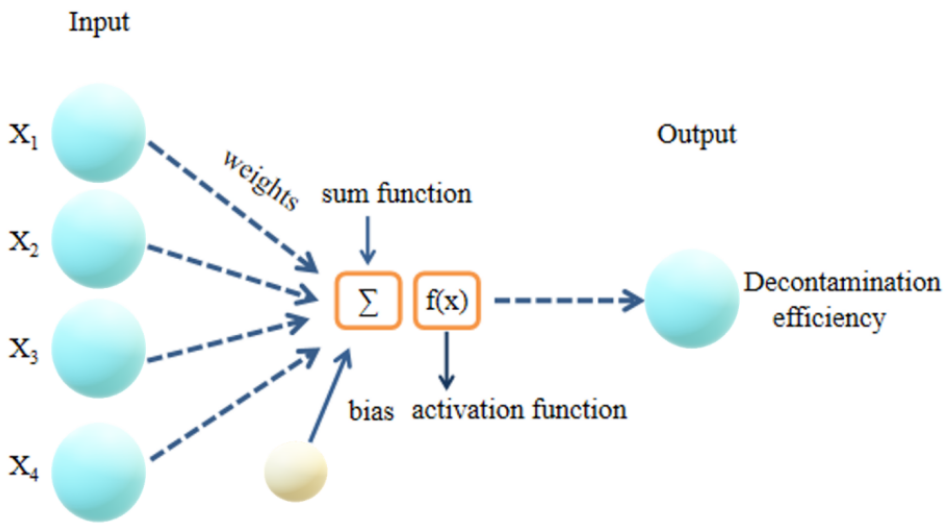
Figure 3. The schematic diagram for the artificial neuron model.